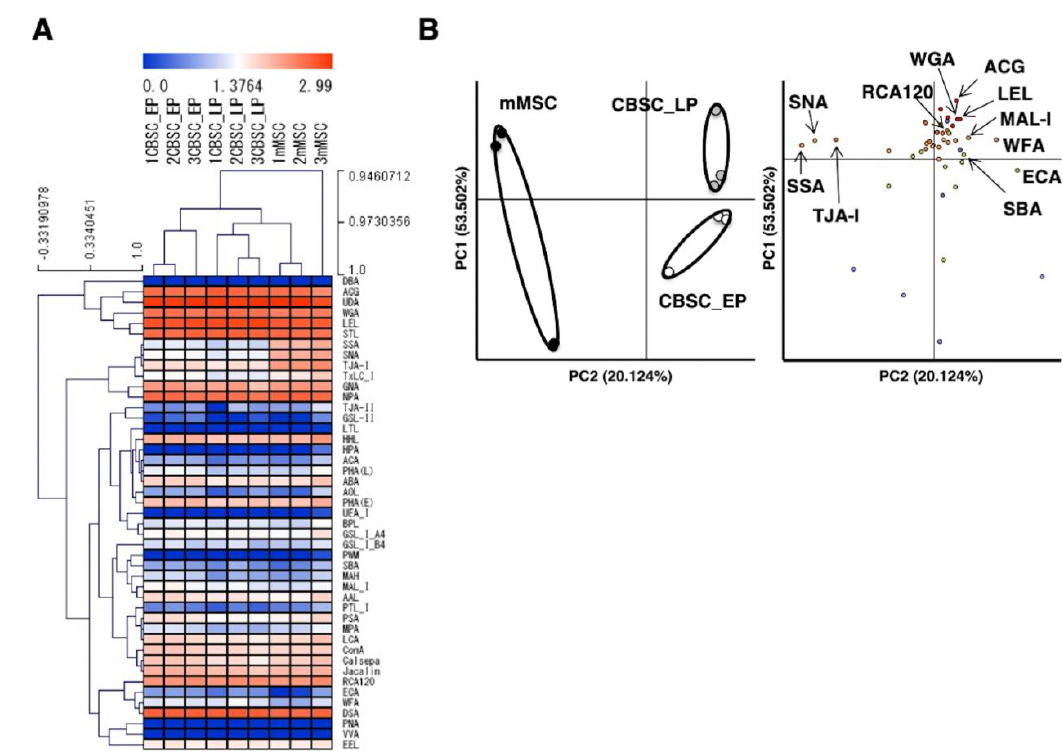
Figure 4. Comparison of glycan profiles between mCBSCs and mMSCs using statistical analysis. ( A ) Heat map repre- sentation of the (log10-transformed) lectin microarray data. The rows represent the lectins, and the columns represent EP-mCBSCs, LP-mCBSCs, and mMSCs with each three cells. The color scale indicates low (blue) to high (red) signal intensity. This figure shows the correlation among three types of cells by hierarchical clustering. ( B ) Biplot for principal component analysis. Left panel: cell replications; right panel: lectin replications shown as a biplot. Closed, open, and gray circles show mMSCs, EP-mCBSCs, and LP-CBSCs, respectively. Abbreviations: mMSC, mouse mesenchymal stem cell; mCBSC, mouse cortical-bone-derived stem cell; EP, early passage; LP, late passage.